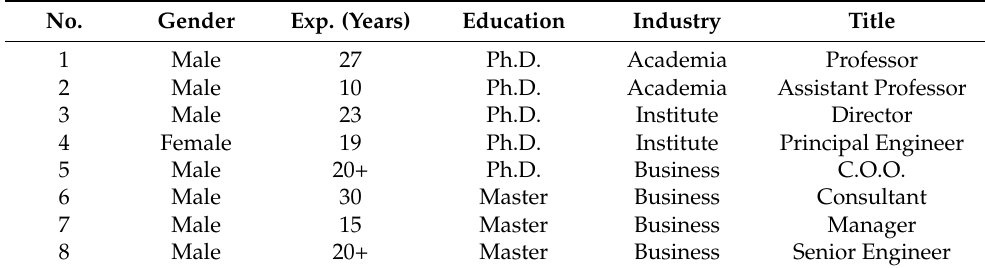
Table 1. The list of experts.